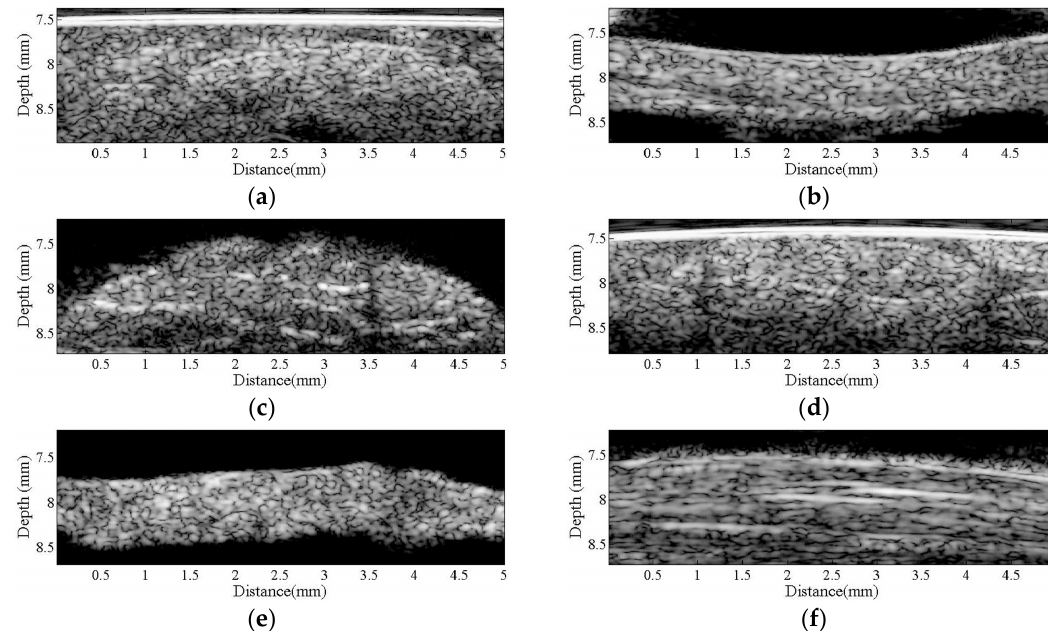
Figure 2. B-mode images of ( a ) hypodermis; ( b ) A1 pulley; and ( c ) SDFT were acquired in the sagittal plane, and those acquired in the transverse plane correspond to ( d – f ), respectively.